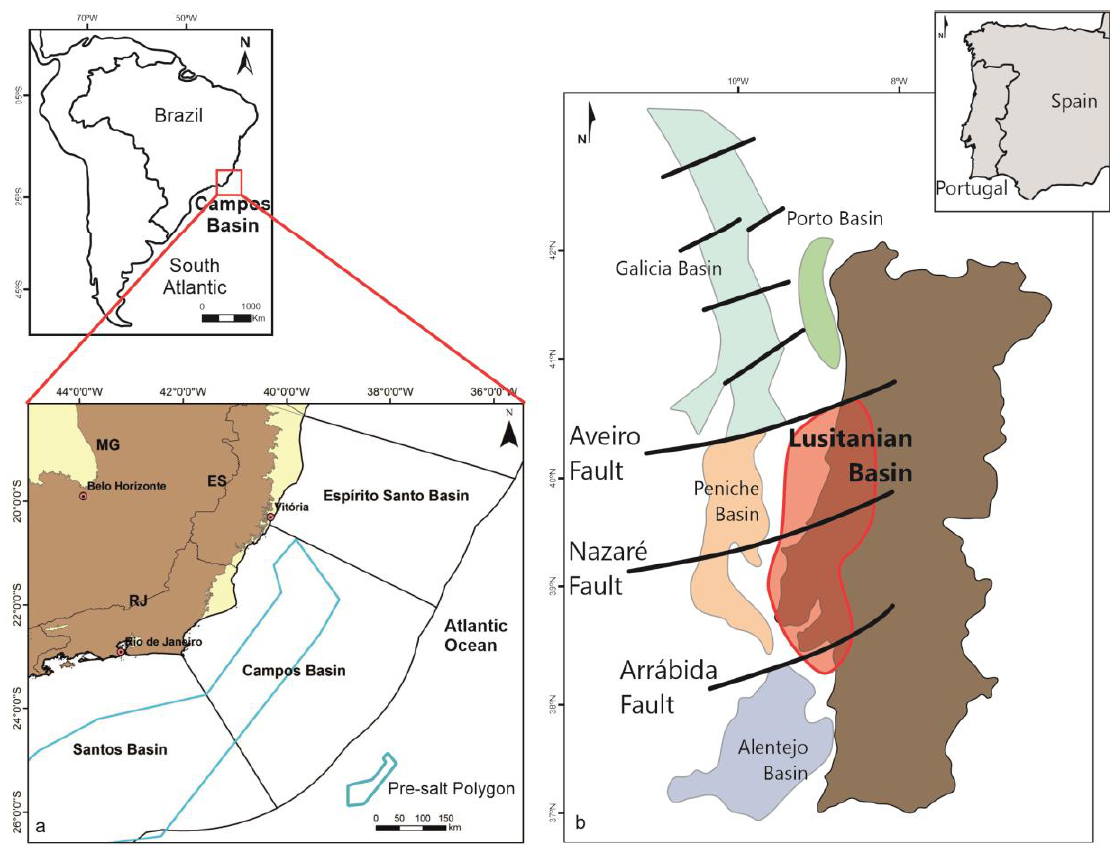
Figure 1. Location maps of the Campos Basin ( a ), adapted from Bastos, [5] and the Lusitanian Basin ( b ), adapted from Pena dos Reis and Pimentel [6], in Brazil and Portugal,